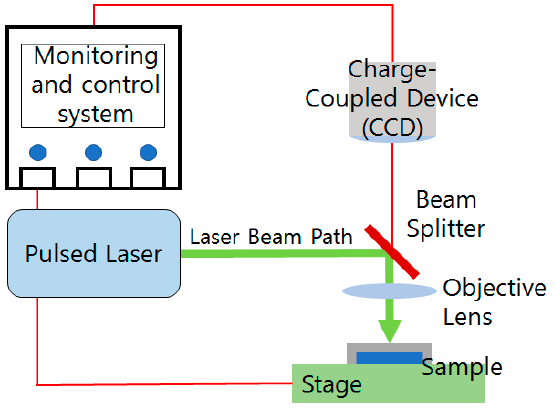
Figure 3. Schematic diagram of the experimental setup.